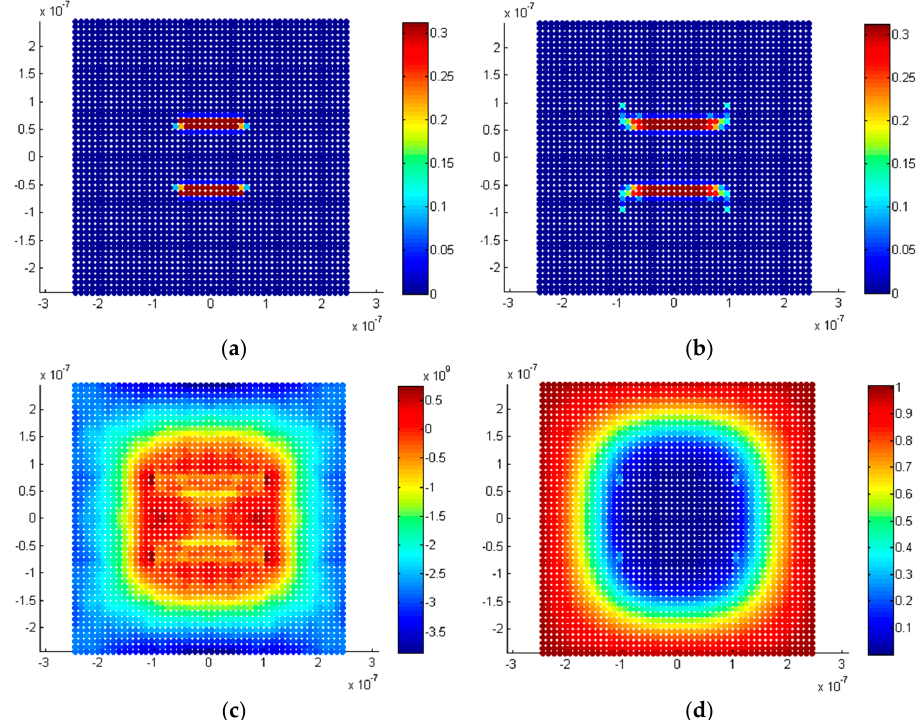
Figure 13. Result plots of a silicon cylinder with twin horizontal cracks in the x - z mid-plane: ( a ) initial damage; ( b ) damage after deformation; ( c ) hydrostatic stress; and ( d ) lithium ion concentration.